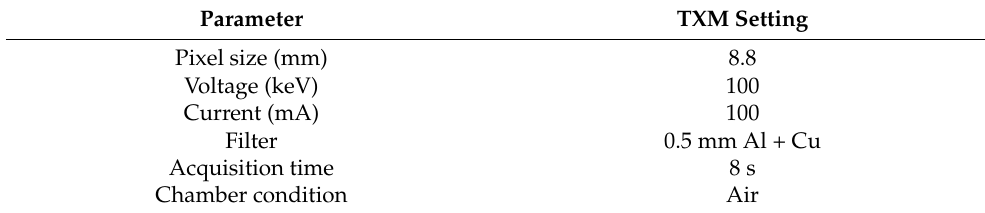
Table 1. Settings used in TXM technique.